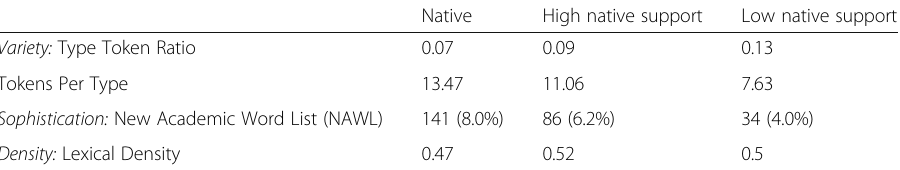
Table 3 Indicators for content